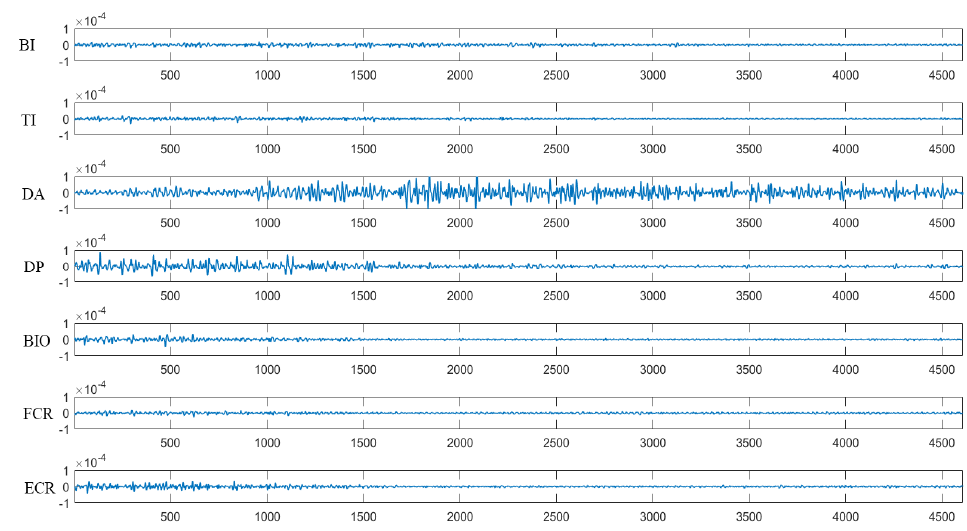
Figure 2. Raw EMG data recorded during the trial of one healthy subject. The unit of the Y coordinate is V.